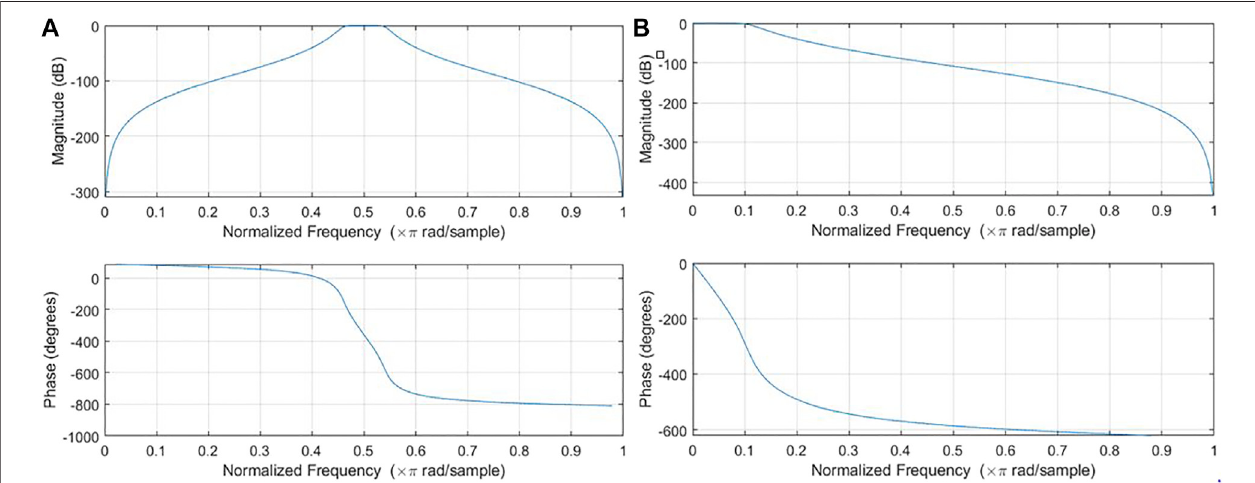
FIGURE 7 | Amplitude and phase-frequency response of fi lters. (A) Bandpass fi lter. (B) Lowpass fi lter.